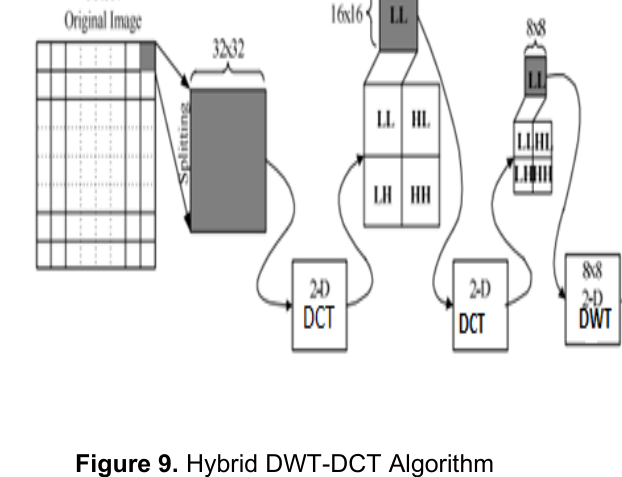
Figure 9. Hybrid DWT-DCT